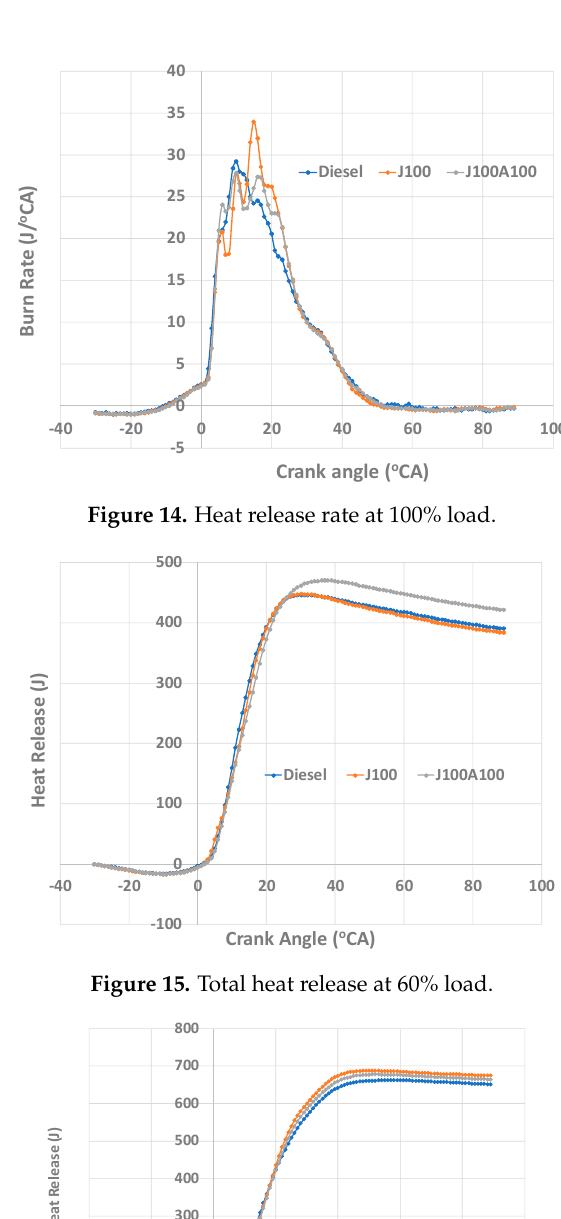
Figure 13. Heat release rate at 60% load.